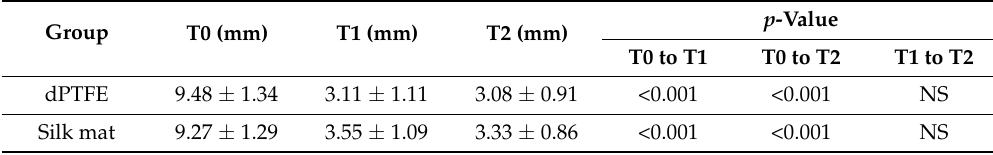
Table 1. Summary of probing depth in patients who received membranes. Group